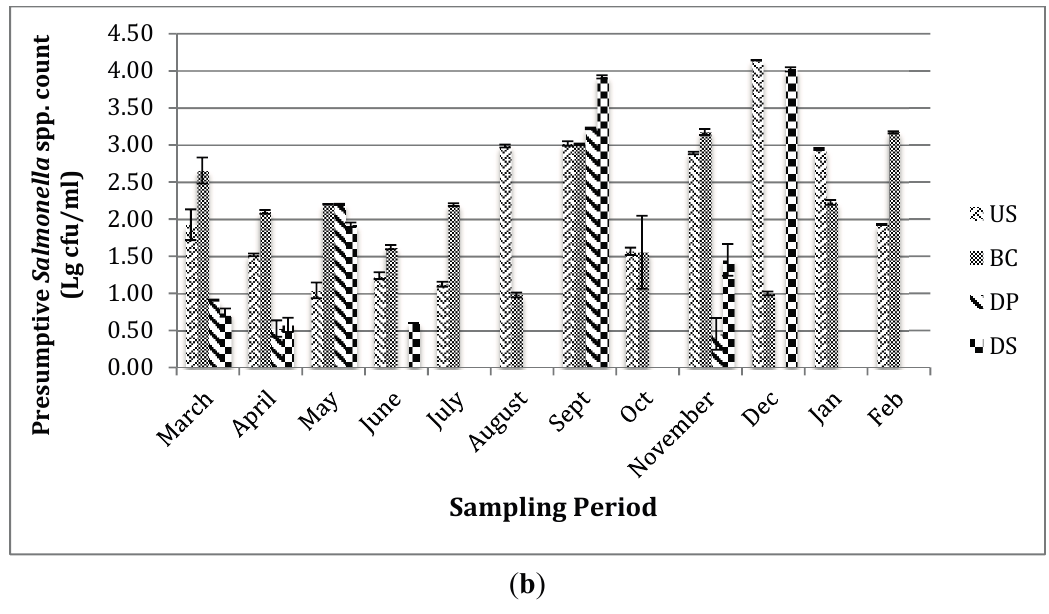
Figure 1. ( a ) Monthly variation of presumptive Salmonella spp. at ( a ) NWWTP and ( b ) NGWTP and their receiving surface waters during the study period.